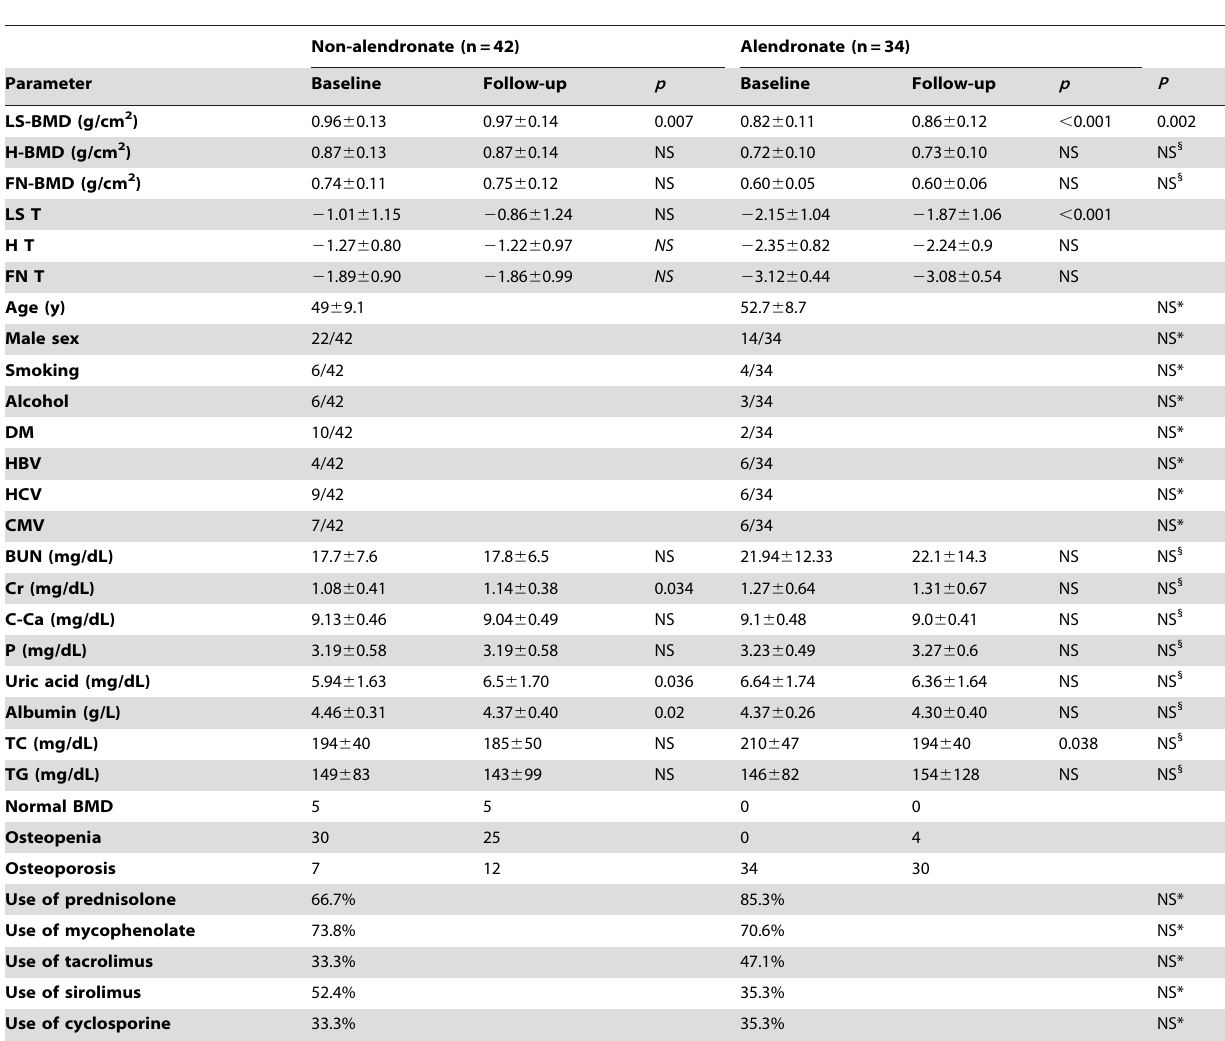
Table 3. Baseline and follow-up data for non–alendronate and alendronate